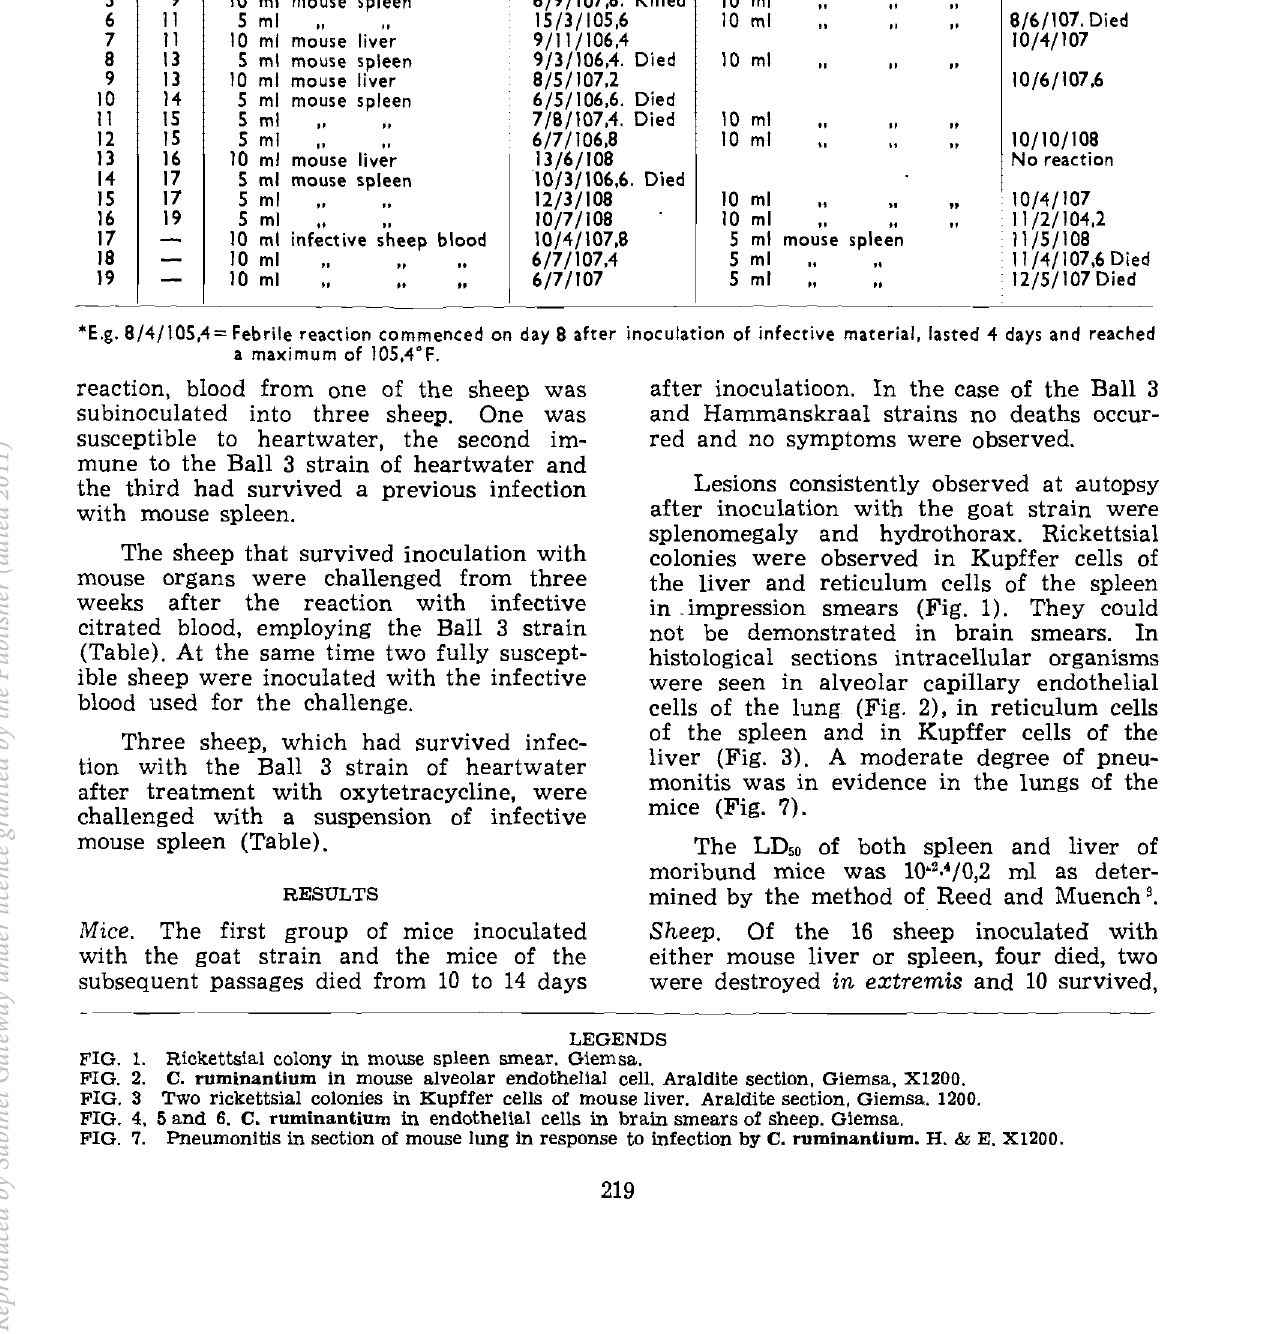
Table: RESULTS OF SHEEP INOCULATED WITH MOUSE LIVER AND SPLEEN AND SUBSEQUENTLY CHALLENGED WITH HEARTWATER BLOOD *E.g. 8/4/105.4==Febrile reaction commenced on 8th day after inoculation of infective material. lasted for 4 days and reached a maximum of 105.4DF.